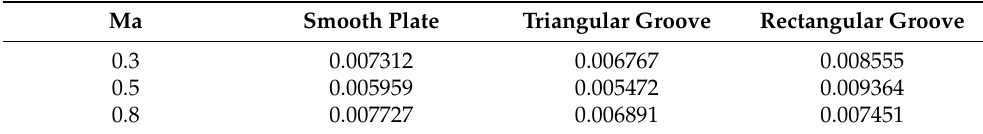
Table 3. Frictional drag coefficient of plates with different surfaces at different speeds.